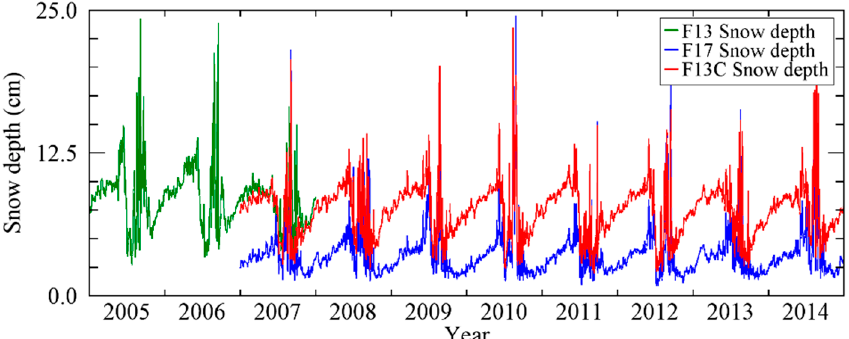
Figure 5. Comparison among F13 SD, F17 SD and F13C SD. F13 SD from 2005 to 2007 are drawn in green line, F17 SD from 2007 to 2014 are drawn in blue line, and F13C SD from 2007 to 2014 are drawn in red line.